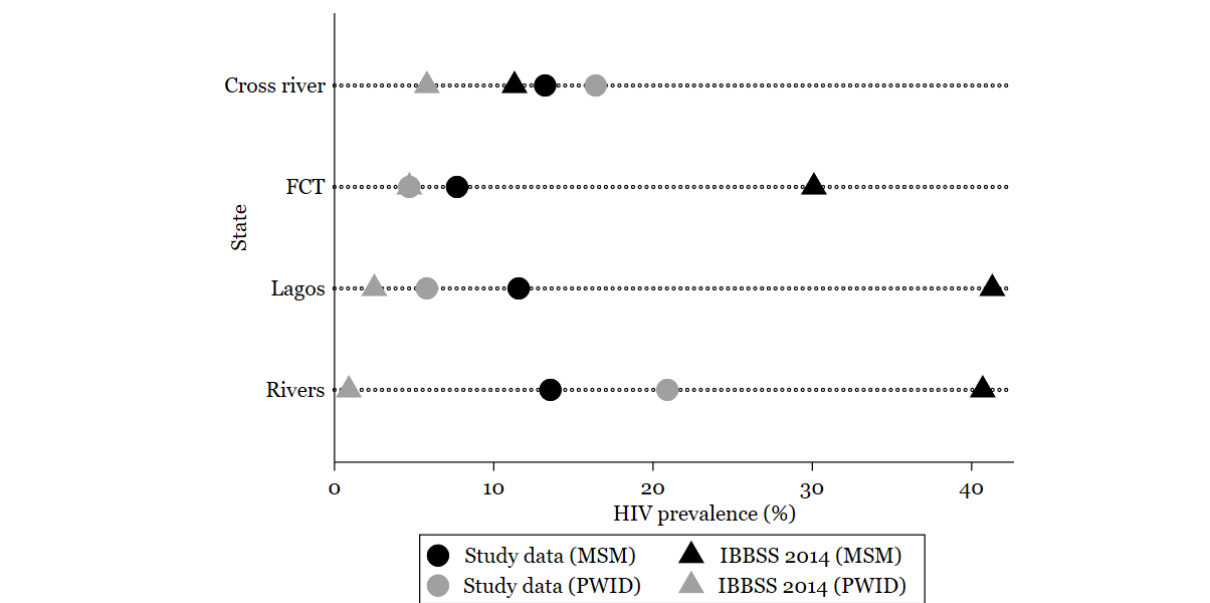
Figure 2. Comparison of HIV seroprevalence from the study to that in the 2014 IBBSS. The black circles and black triangles represent HIV seroprevalence among MSM as seen in our analysis and the 2014 IBBSS, respectively. The grey circles and grey triangles represent the PWID HIV seroprevalence as seen in our study and the 2014 IBBSS, respectively. FCT: Federal Capital Territory; IBSS: integrated biological and behavioural surveillance survey: MSM: men who have sex with men; PWID: people who inject